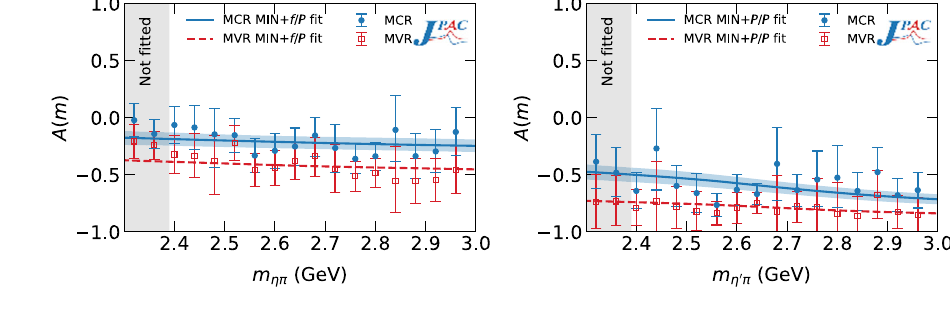
Fig. 22 Forward–backward intensity asymmetry as defined in Eq. (5) for ηπ (left) and η (cid:2) π (right) for both MCR and MVR. We show as experimental MVR error bars the same computed from the MCR